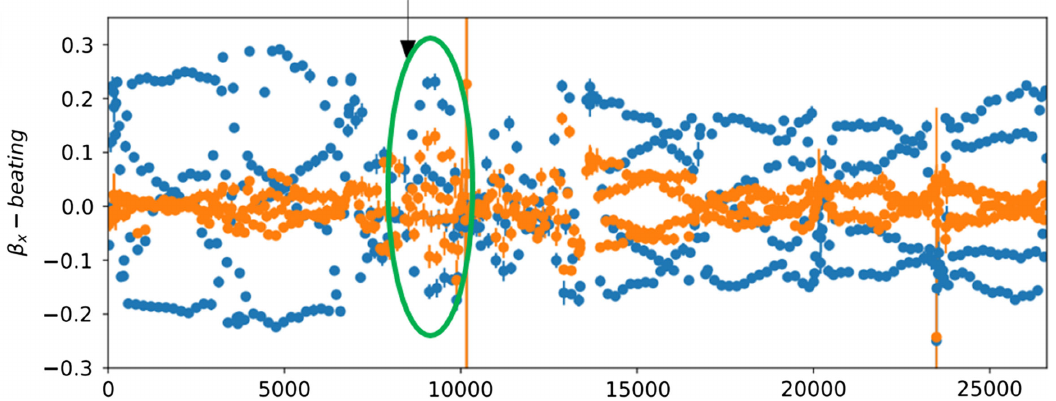
FIG. 12. β -beating [%] measured before and after correction at β (cid:1) jj ;X ¼ ð 60 ; 15 Þ cm (case of Beam1H). The β -beating at mid-arc in sector 45 (emphasized by the green oval) is improved thanks to an orbit bump and the resulting quadrupolar feed-down effects from the lattice sextupoles (knowing that no standalone quadrupoles is available at this ring